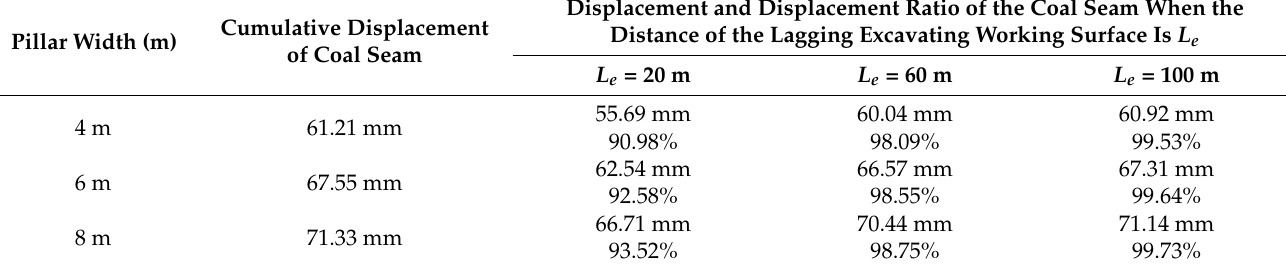
Figure 16. Roof subsidence shape diagram during the excavation of the different yield pillar widths. Table 5. Evolution of coal seam displacement during roadway driving with different yield pillar